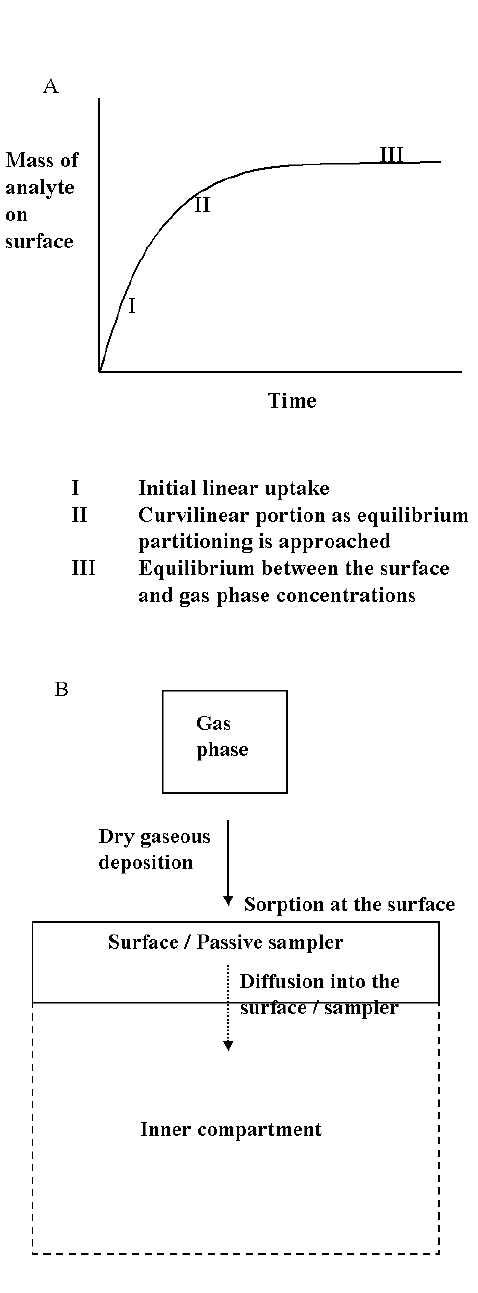
FIGURE 3. Schematic of the uptake of gas phase compounds by a surface/passive